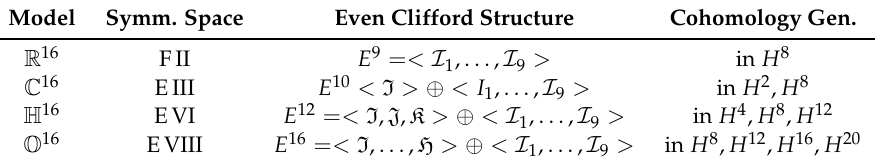
Table 5. Even Clifford structures on the Cayley–Rosenfeld projective